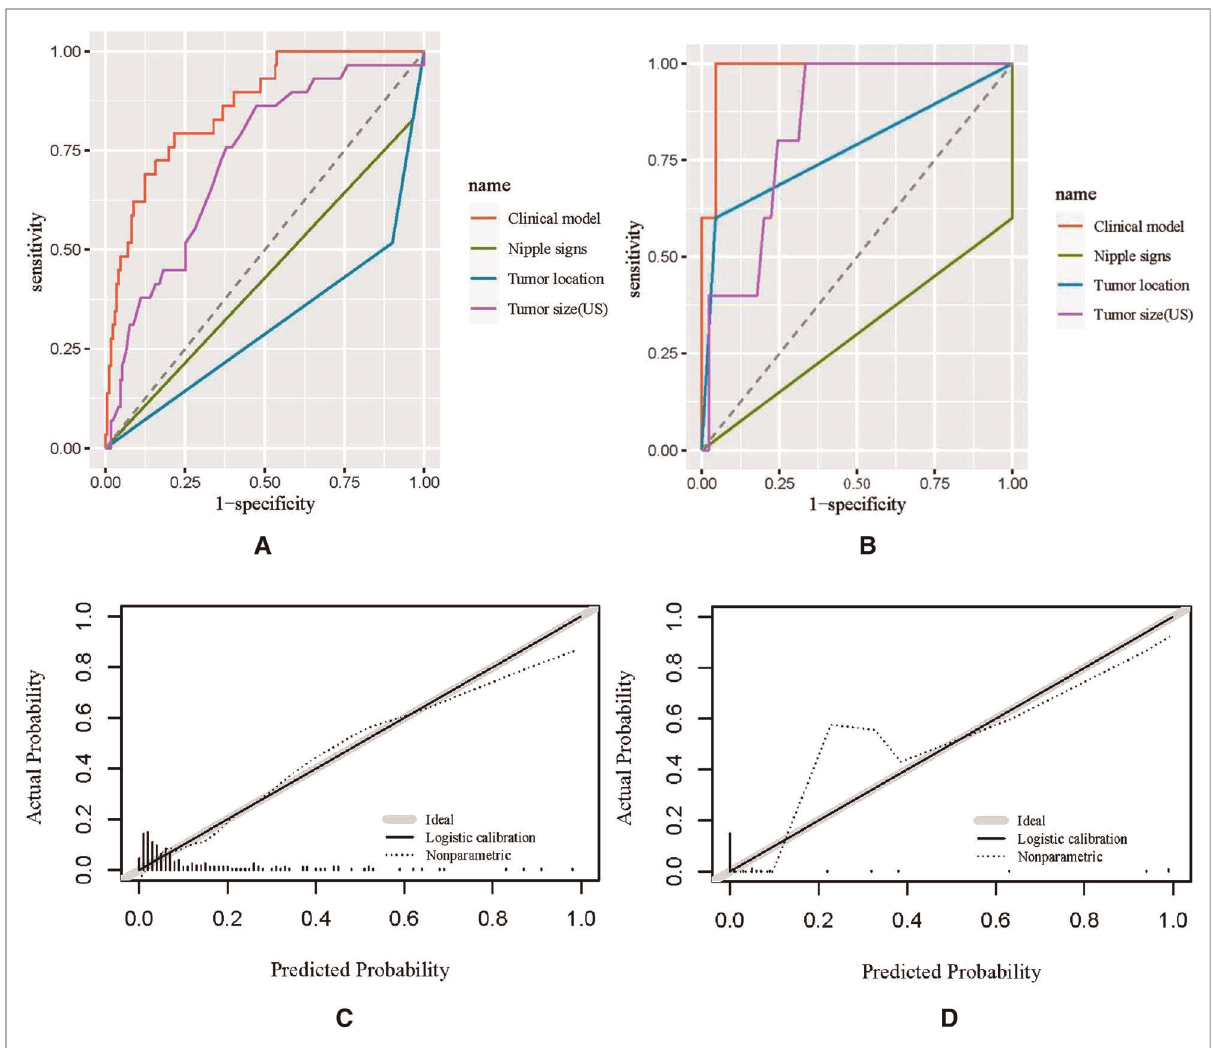
FIGURE 2 Receiver operating characteristic (ROC) curves and calibration curves. ( A,B ) ROC curves of the training group and the validation group; ( C,D ) calibration curves of the nomogram in the training group and the validation group. US,